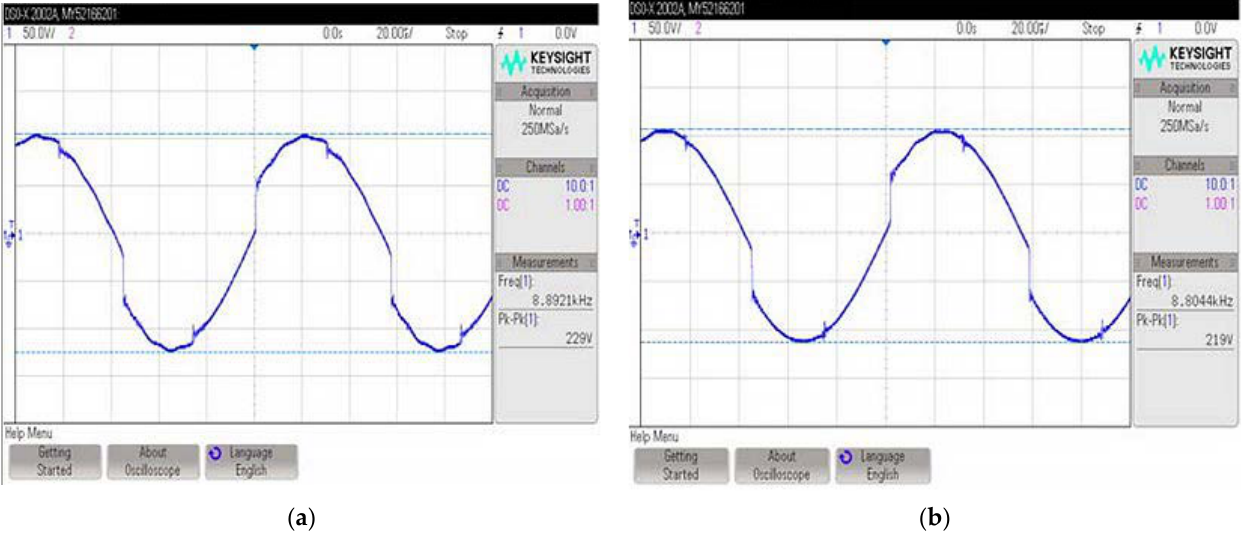
Figure 16. ( a ) The frequency signal of the heater set 1 at a frequency of 8.892 kHz. ( b ) The frequency signal of the second set of heaters at a frequency of 8.804 kHz.